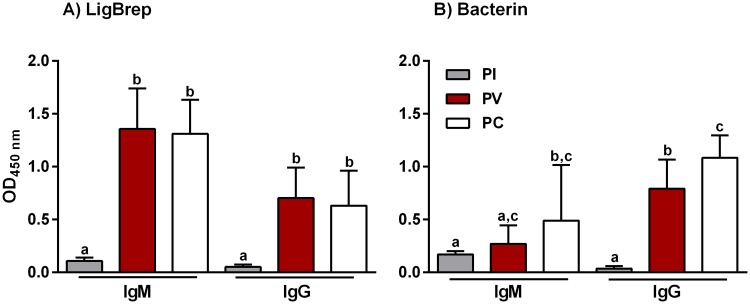
IgM and IgG induced by rLigB(131–645).ELISAs were performed to determine antibody levels in hamsters immunized with A) rLigB(131–645)/AH (80/40 μg) or B) bacterin vaccine (see Table 1). Pre-immune (PI), post-vaccination (PV) and post-challenge (PC) serum samples were collected and characterized at a single serum dilution (1:100) with anti-hamster IgM and IgG secondary antibodies. The mean optical density (OD450 nm) ± standard deviation (bars) from three independent experiments are shown. Significance was determined by one-way ANOVA (Tukey multiple comparison) analysis, the presence of lower case letters, where different, indicates a significant difference (P < 0.05) between samples.